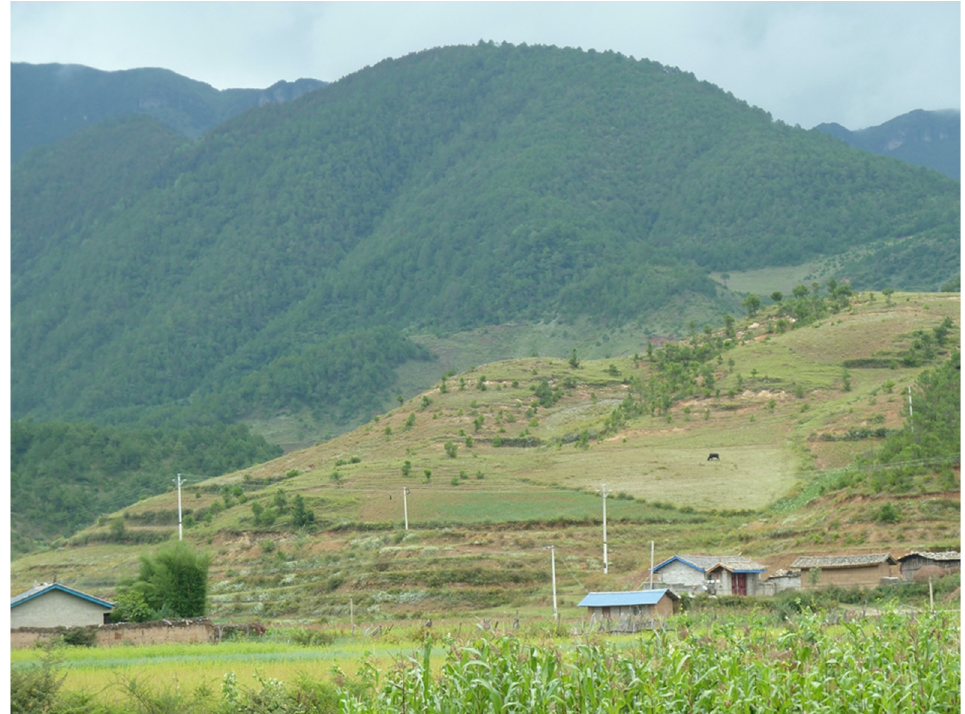
Figure 4. A mountain where a land spirit resides, which is off limits for human use, stands behind smaller mountains used for swidden agriculture and wood harvesting, Niplat, 2015. Photograph by the author.